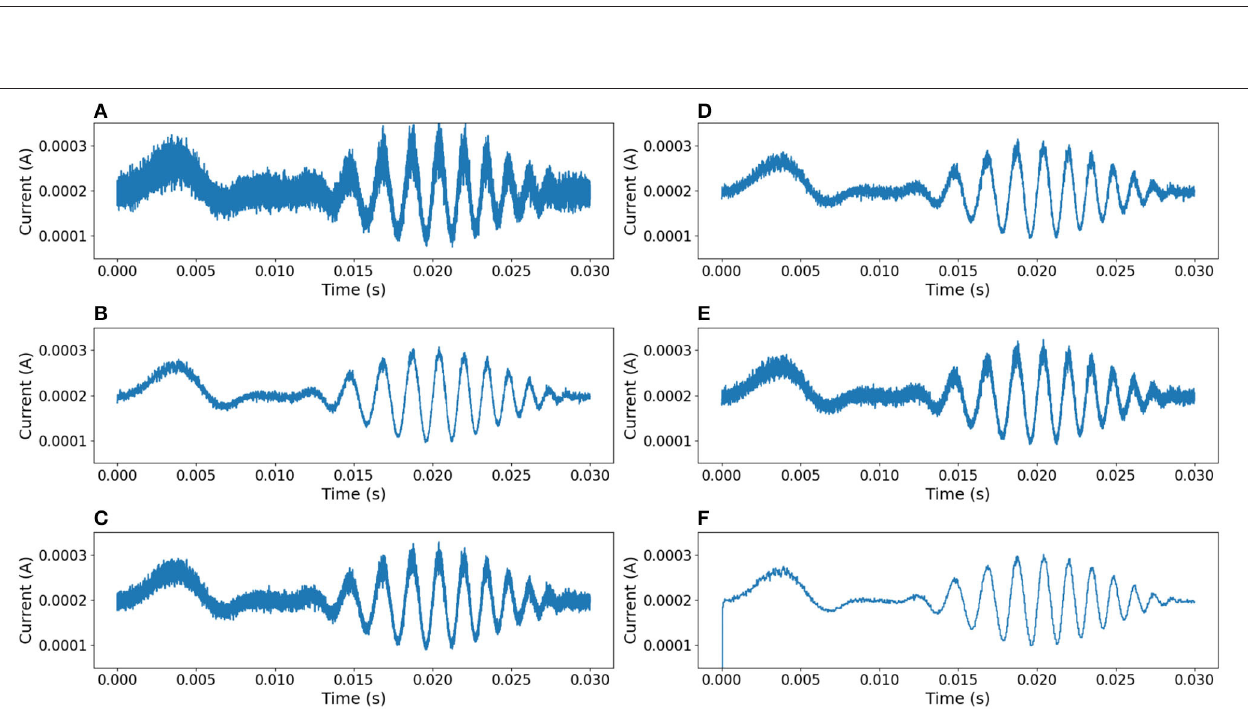
FIGURE 12 | Comparison of results between different filters, using a signal affected by Gaussian Multiplicative Noise of 30% . (A) Median filter. (B) 3rd-order Chebyshev type 1 filter with cutoff frequency at 55 kHz . (C) 3rd-order Chebyshev type 2 filter with cutoff frequency at 55 kHz . (D) 3rd-order Butterworth filter with cutoff frequency at 55 kHz . (E) 3rd-order Elliptic filter with cutoff frequency at 55 kHz . (F) Neural filter proposed.